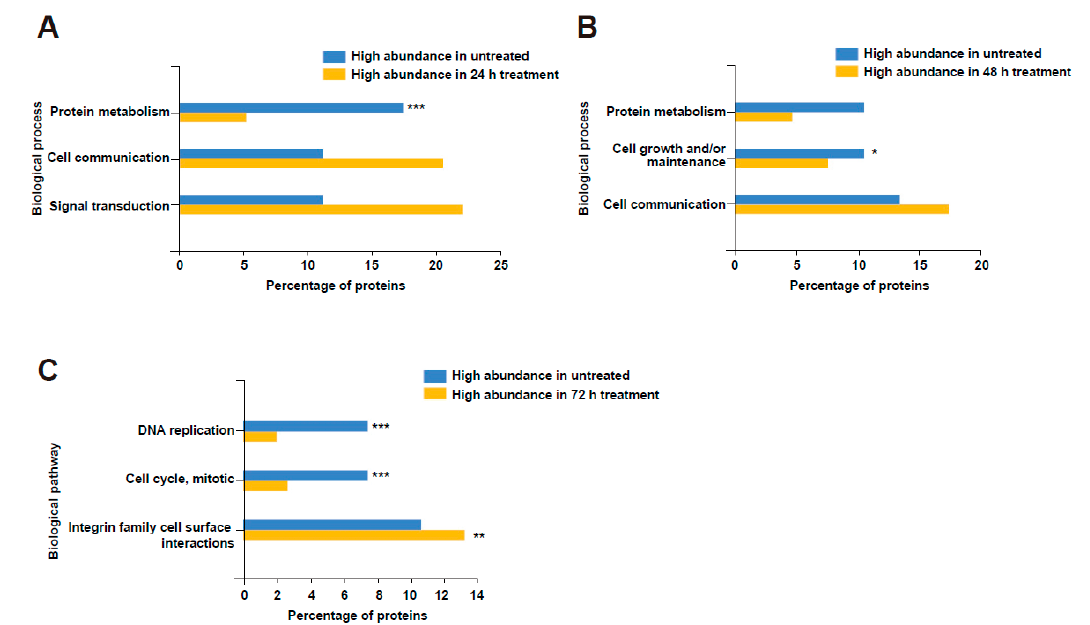
Figure 5. Gene enrichment analysis revealed the enrichment of proteins involved in cellular growth in untreated NBL cells. ( A ) Proteins that are 2-fold differentially abundant in 24 h treated and untreated NBL cells were subjected to enrichment analysis for biological process. ( B ) Proteins that are 2-fold differentially abundant in 48 h treated and untreated NBL cells were subjected to enrichment analysis for biological process. ( C ) Gene enrichment analysis of biological pathways affected by MEV treatment at 72 h. * denotes p < 0.05, ** denotes p < 0.01 and *** denotes p < 0.001 as determined by hypergeometric test.